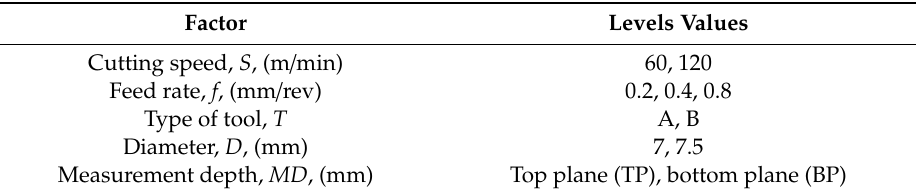
Table 2. Factors and their levels.